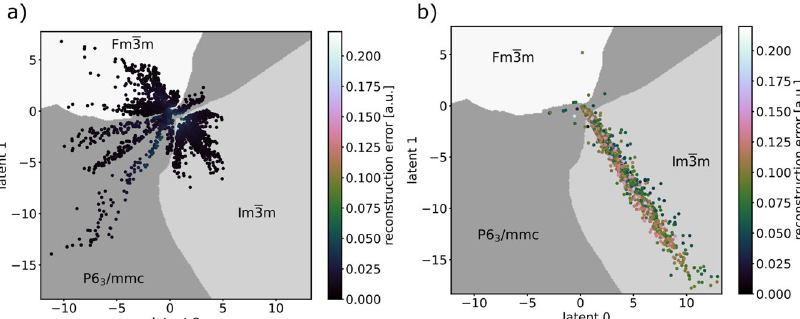
Fig. 2 Classi fi cation and novelty detection using the reconstruction error. The decision boundaries of a KNN classi fi er are outlined. a Latent space representation of a known phase color-coded by the reconstruction error. b Latent space representation of an unknown phase color-coded by the reconstruction error. The unknown phase shows a distinctly higher reconstruction error (average reconstruction error = 0.09) compared to phases that are recognized by the model (average reconstruction error = 0.017). The classi fi cation test score in this idealized case was 99.16%.